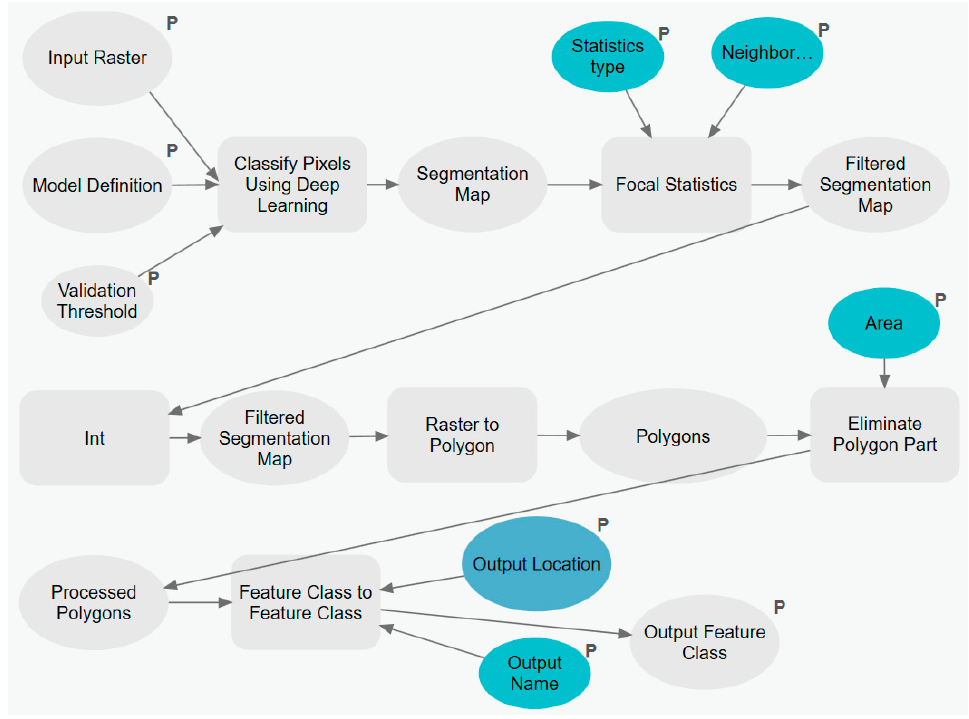
Figure 7. Schematic representation of the processing steps implemented in a toolbox in ArcGIS Pro.